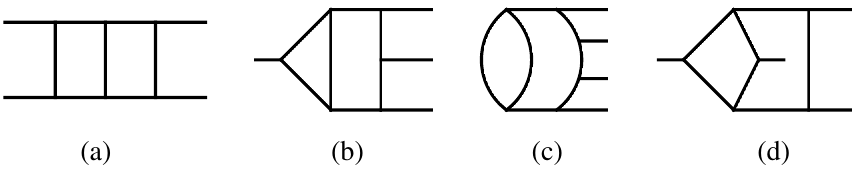
Figure 2. The four basic topologies. The internal lines can be both massive and massless. The first three (a)–(c) are planar and can at most have 5 massive internal lines, while the nonplanar topology (d) can at most have 4 massive internal